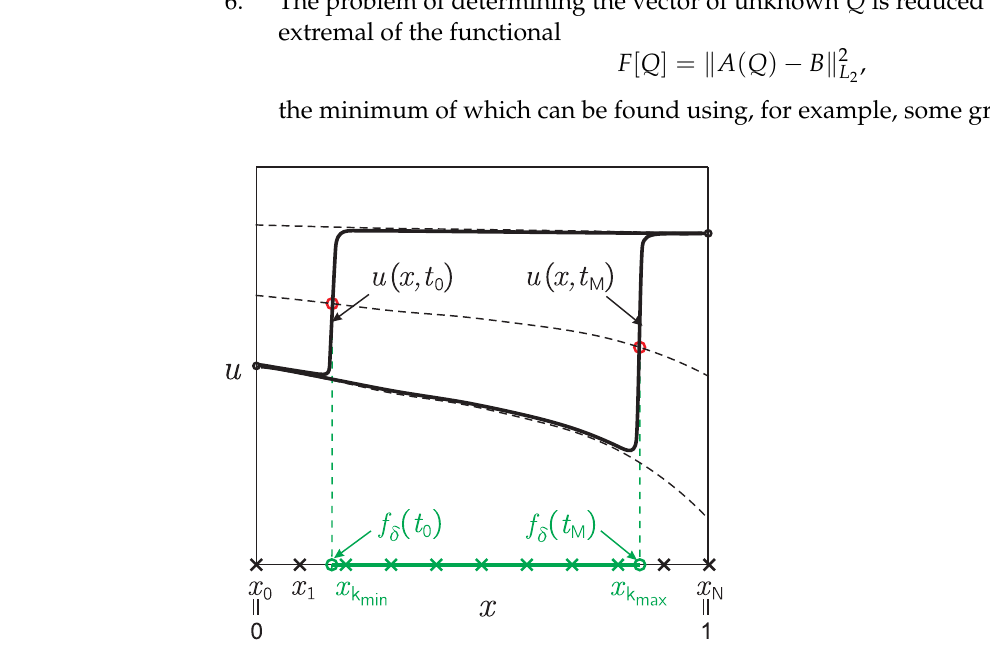
Figure 3. The region passed through by the reaction front during the experimental observations of the function f δ ( t ) ≡ x t . p . ( t )